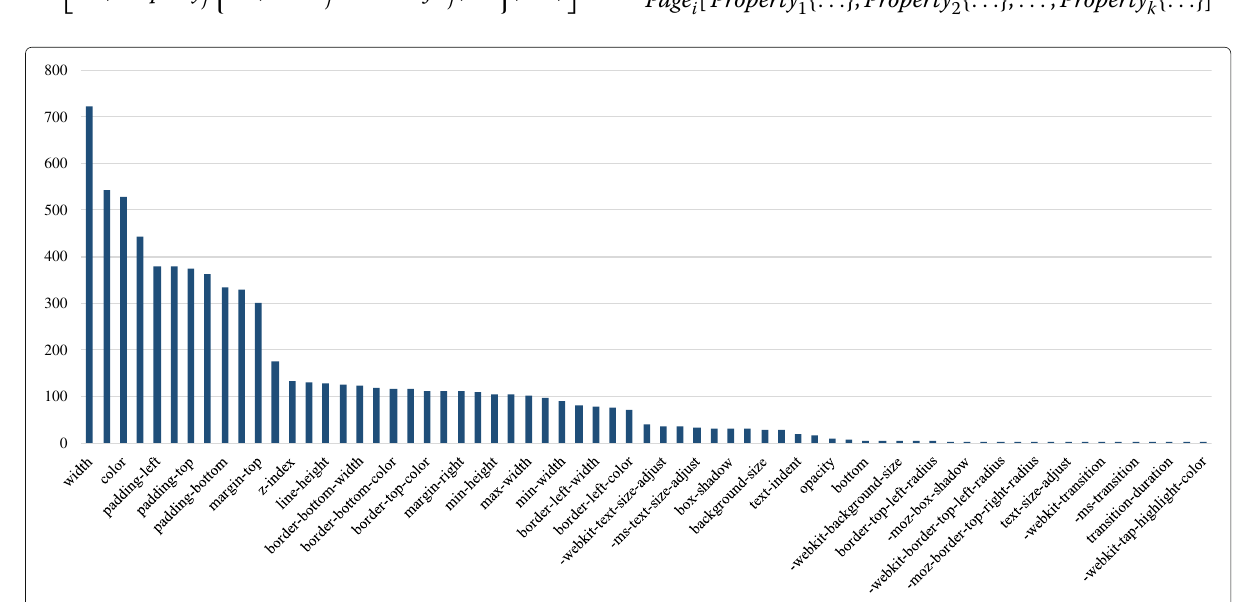
Fig. 2 Distribution of CSS properties. Properties from all the web pages collected for training and